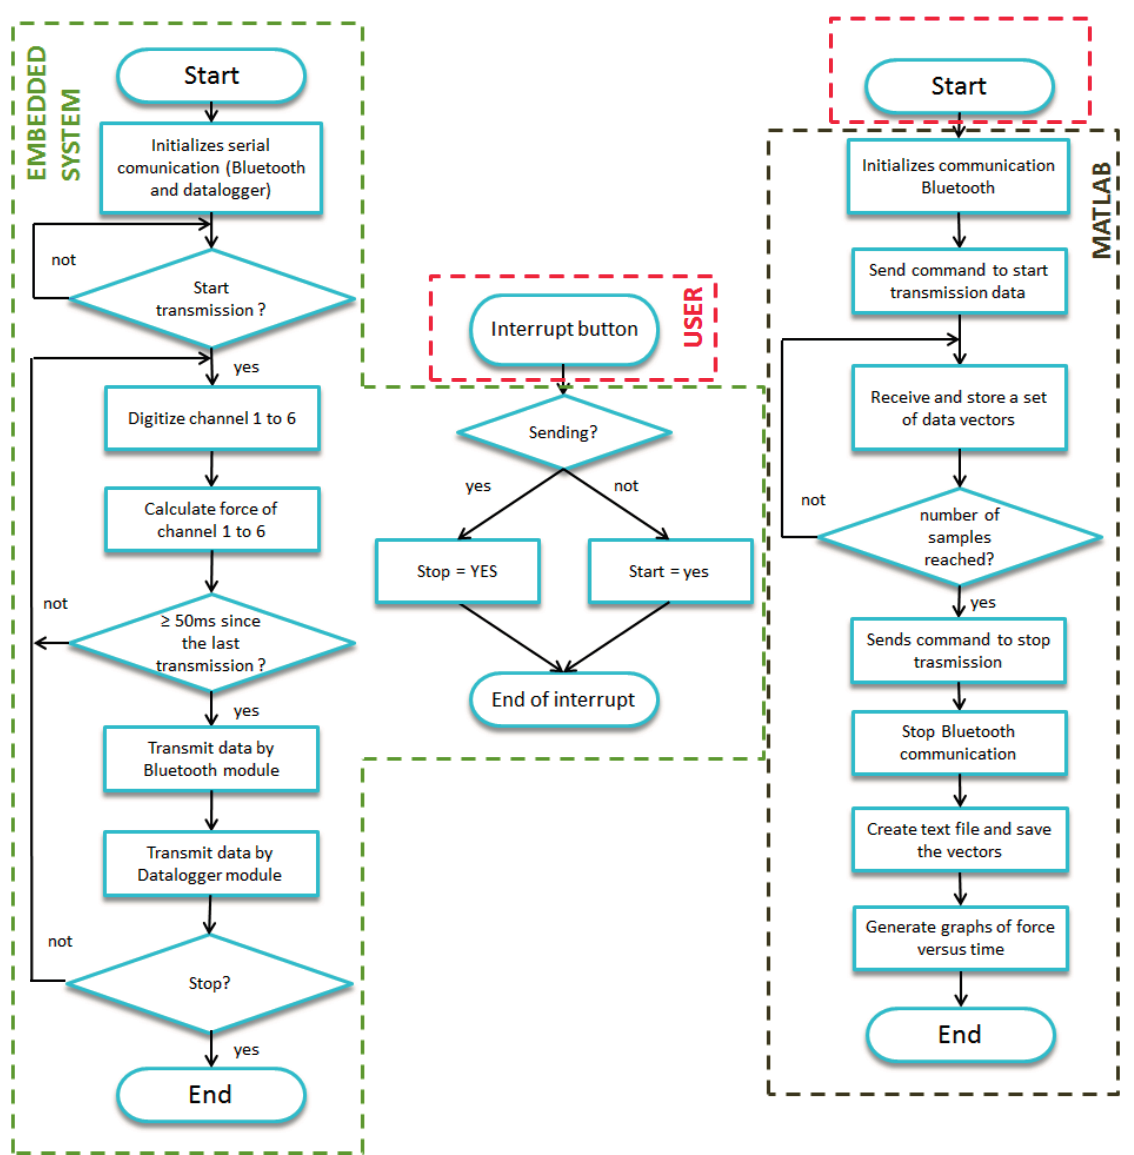
Figure 9. Flowchart of the routine implemented in the Arduino board’s microcontroller and